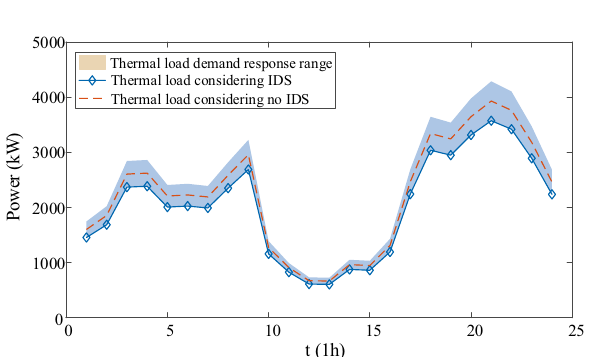
Figure 11. Thermal load comparison considering IDR and no IDR.